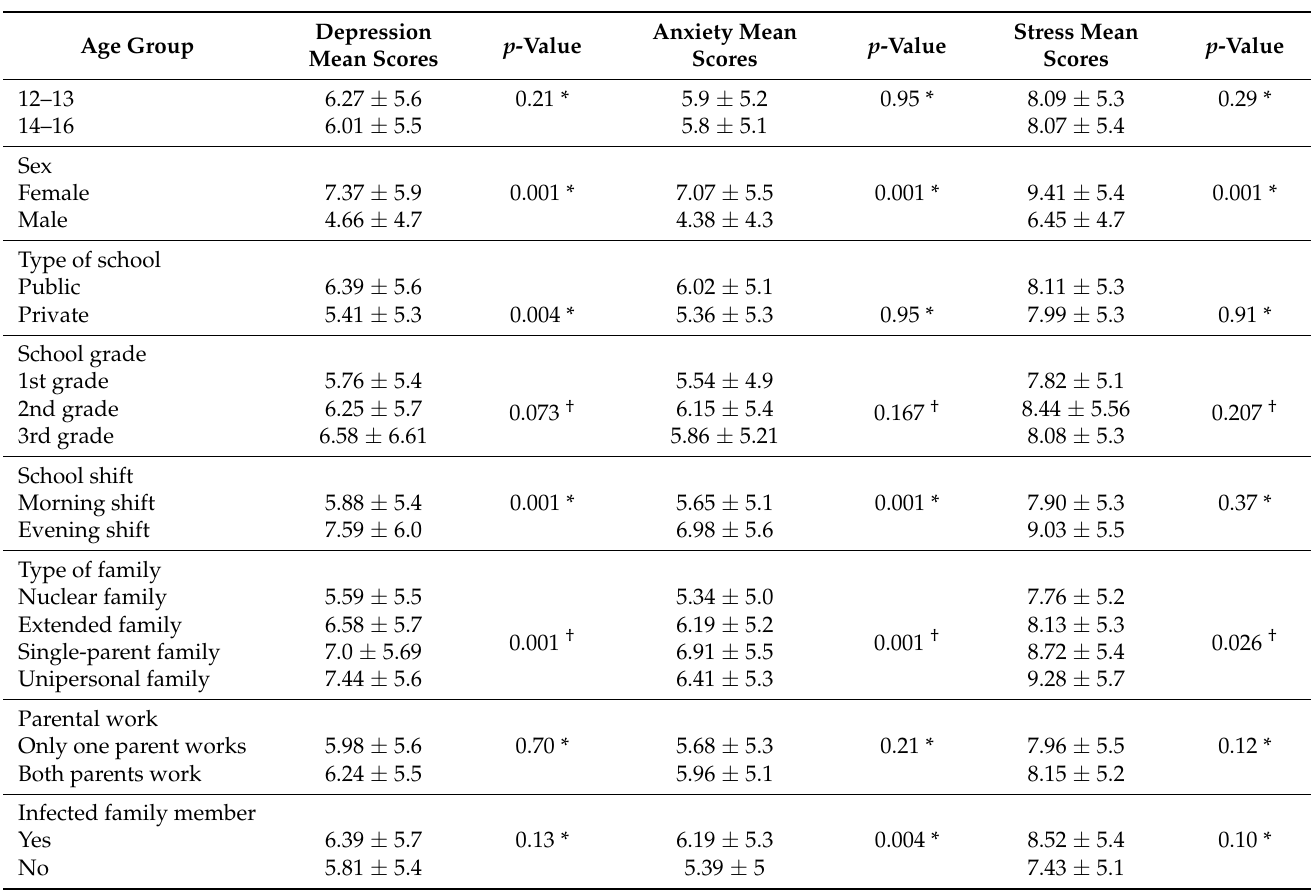
Table 3. DASS-21 scores by age group, sex, type of school, school shift, parental work, and family member infected with